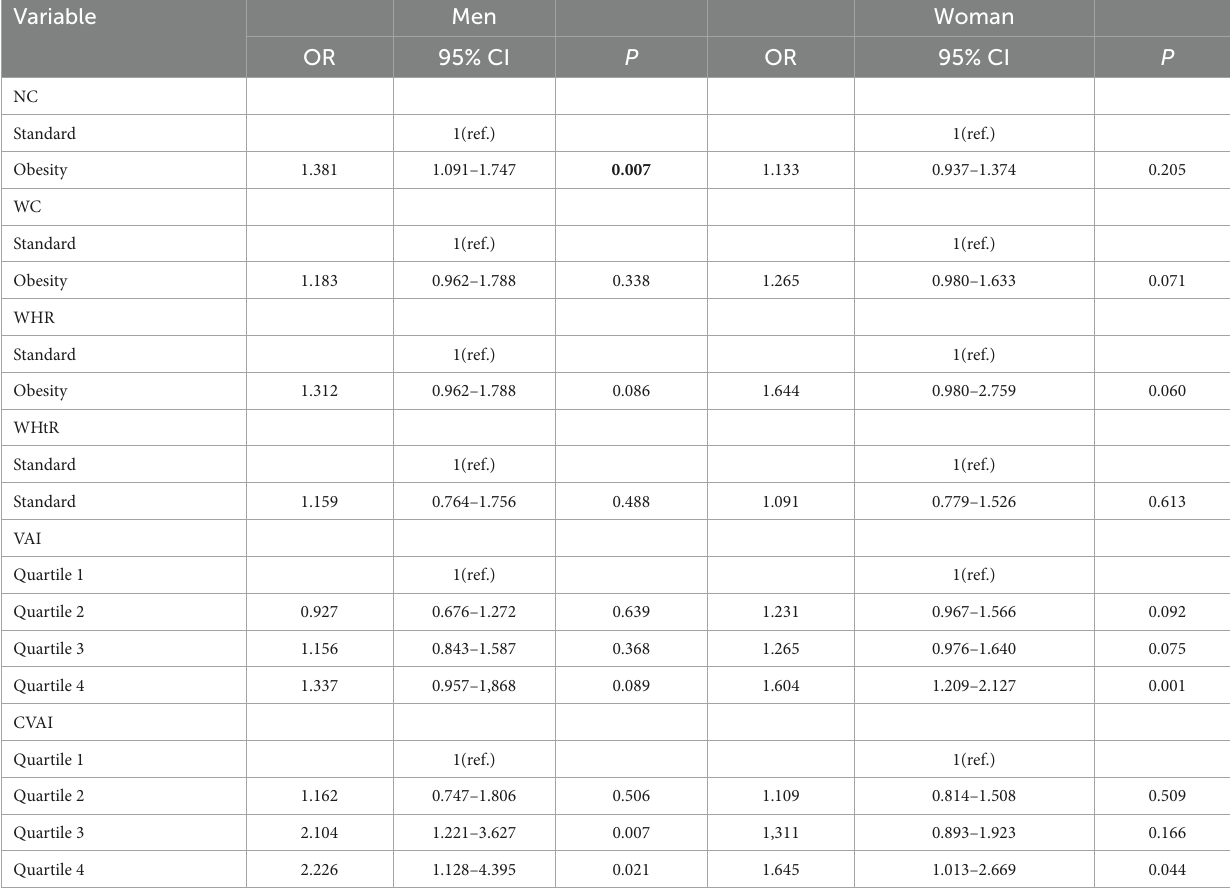
TABLE 2 Multivariate analysis of anthropometric indices and diabetes mellitus in the older individual.